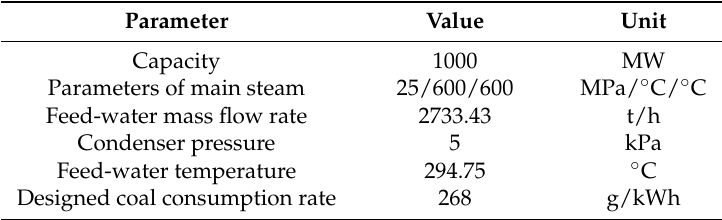
Table 2. Main design parameters of the coal-fired power plant subsystem.